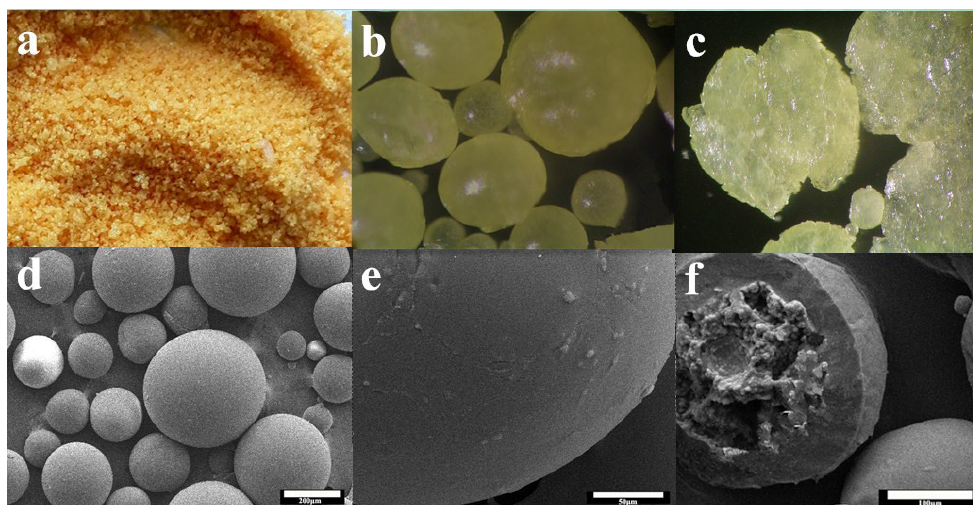
Figure 7. Morphology of microcapsules: ( a ) Digital camera image(Canon, Tokyo, Japan); ( b ) OM image( 100×); ( c ) OM image of flattened microcapsules(100×); ( d ) SEM micrograph with spherical shaped microcapsules; ( e ) zoomed in image showing smooth outer surface; and ( f ) micro structure morphology.